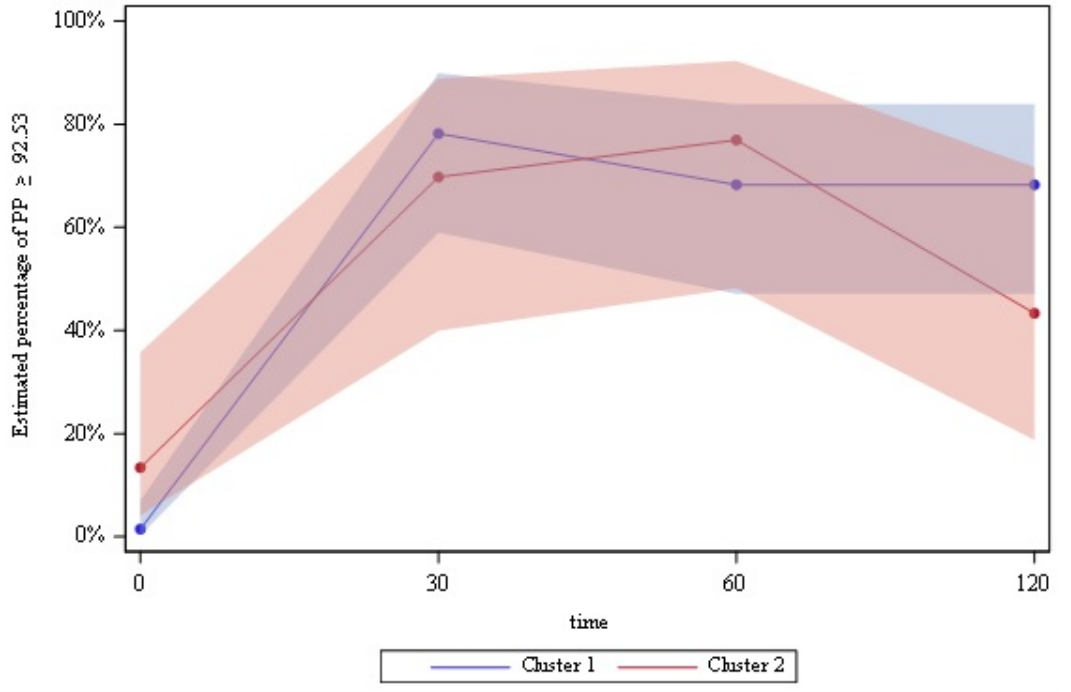
Figure 4. Postprandial PP concentrations in baseline clusters.